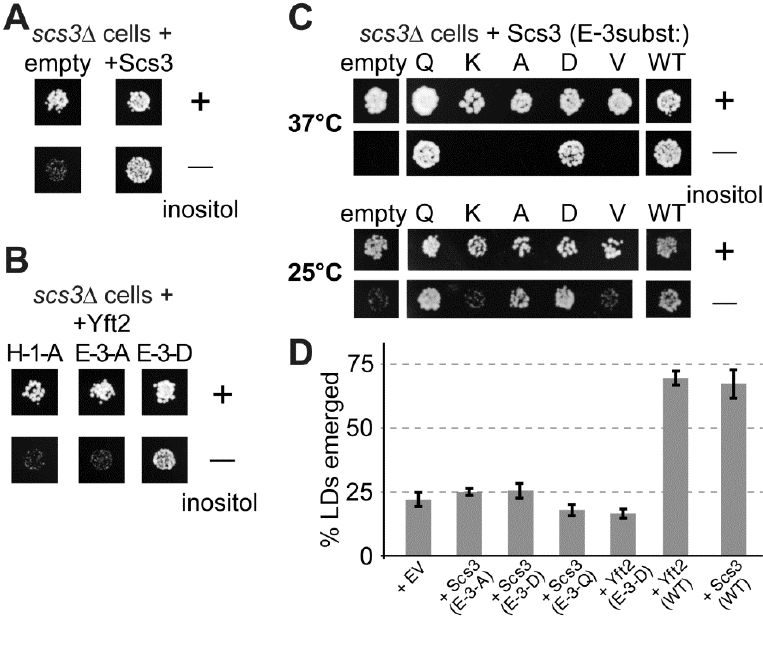
FIGURE 7: Growth of yeast lacking inositol requires FITMs with an intact catalytic triad. (A-C) Equal numbers of scs3 ∆ yeast (~50) transformed with the plasmids indicated were spotted onto plates either with added inositol (100 µM) or without, and grown at 30°C or the temperature indicated for 48-72 hours. (A) Cells either transformed with empty plasmid (expressing GFP alone) or expressing Scs3- GFP. (B) Cells grown in parallel to A, but expressing Yft2-GFP, either mutated H-1-A, E-3-A or E-3-D. (C) Cells were expressed with mutants of Scs3-GFP, substituting E-3 to five other residues. Here cells were grown at high stringency (37°C) or low strin- gency (25°C), the latter allowing rescue by the par- tially active construct E-3-A. (D) Emerged lipid drop- lets were counted in random sections of scs3 ∆ yft2 ∆ yeast expressing the indicated constructs (EV = empty vector), and identified as emerged from the ER by the complete absence of wrapping mem- brane (≥50 cells each experiment, n=3, SD shown by error bars). Emergence, as opposed to remaining wrapped in ER, was scored as previously [26]. This means that the droplets not counted here ( i.e. not emerged) include both the clearly wrapped, and those with an ambiguous morphology (~7% under all